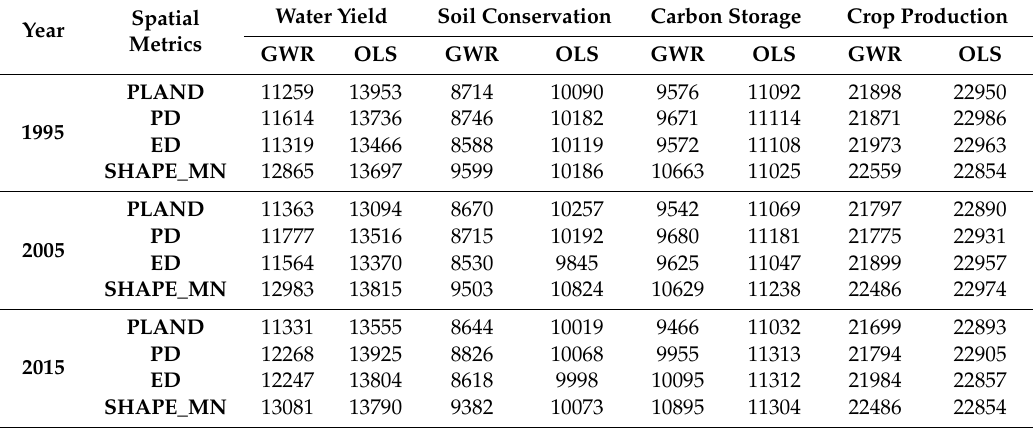
Table 8. Comparison of the Akaike Information Criterion (AICc) between GWR and OLS